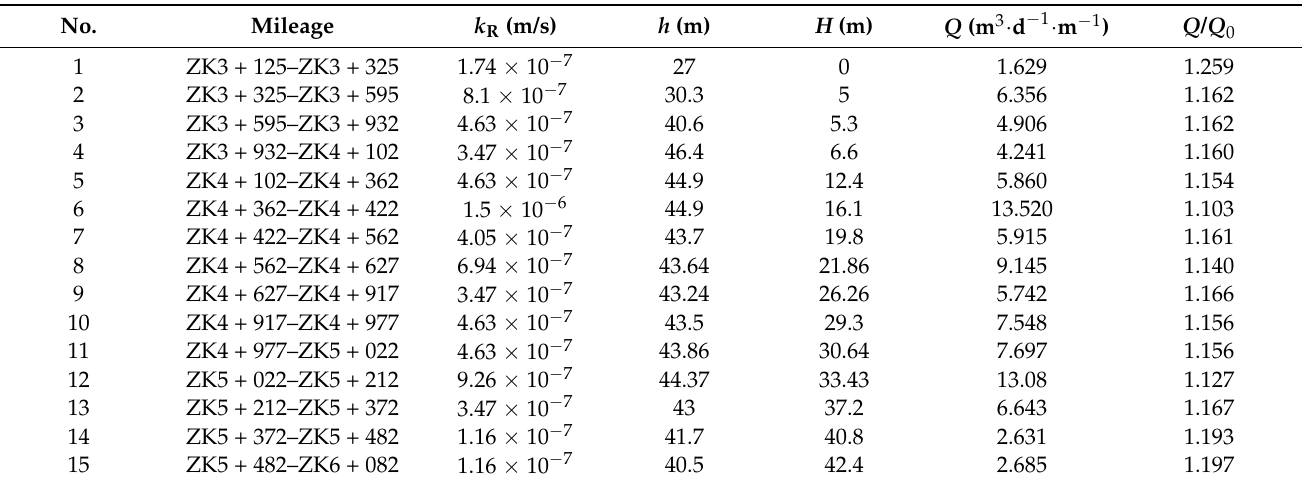
Table 6. Parameters of sections and evaluation